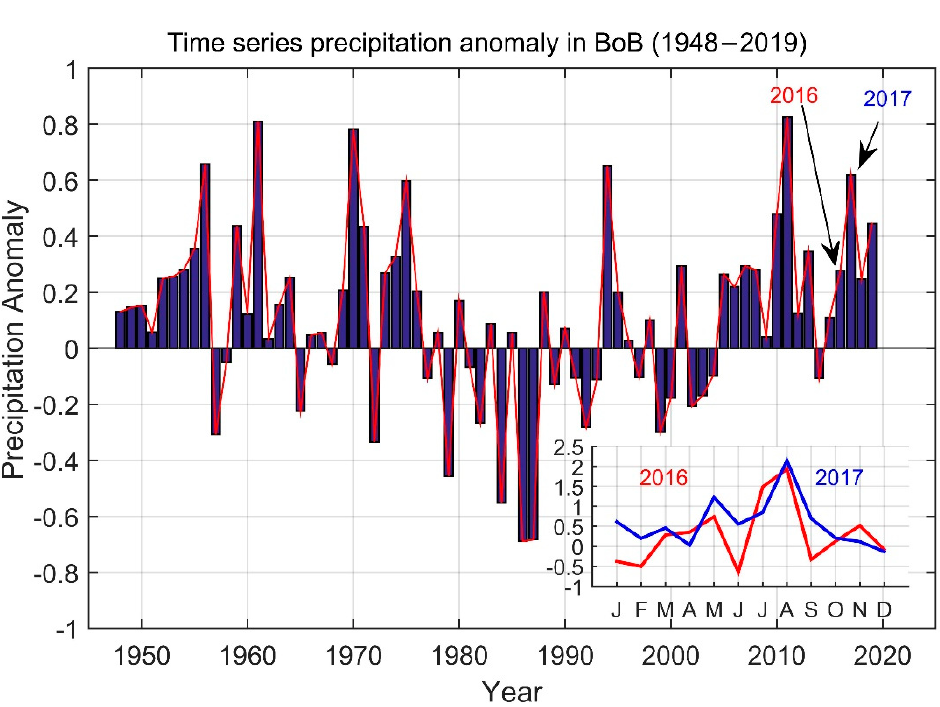
Figure 13. As in Figure 11, but for BoB region.